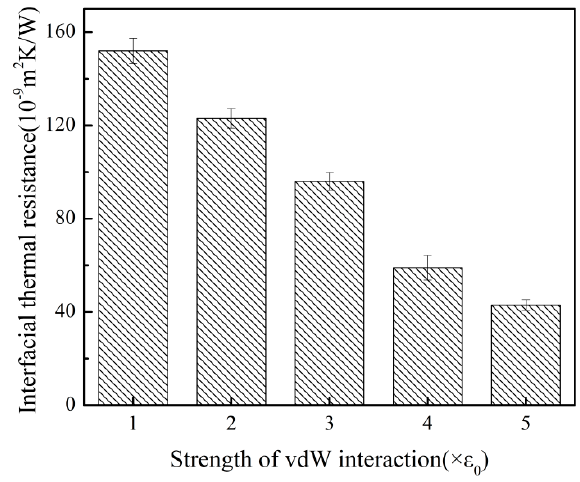
Figure 11. The ITR with different interface interaction strengths.